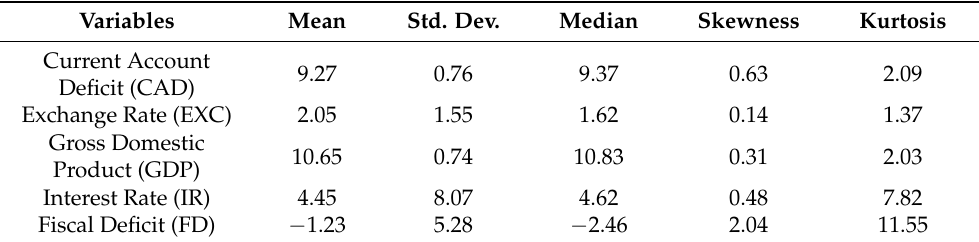
Table 3. Descriptive statistics for panel